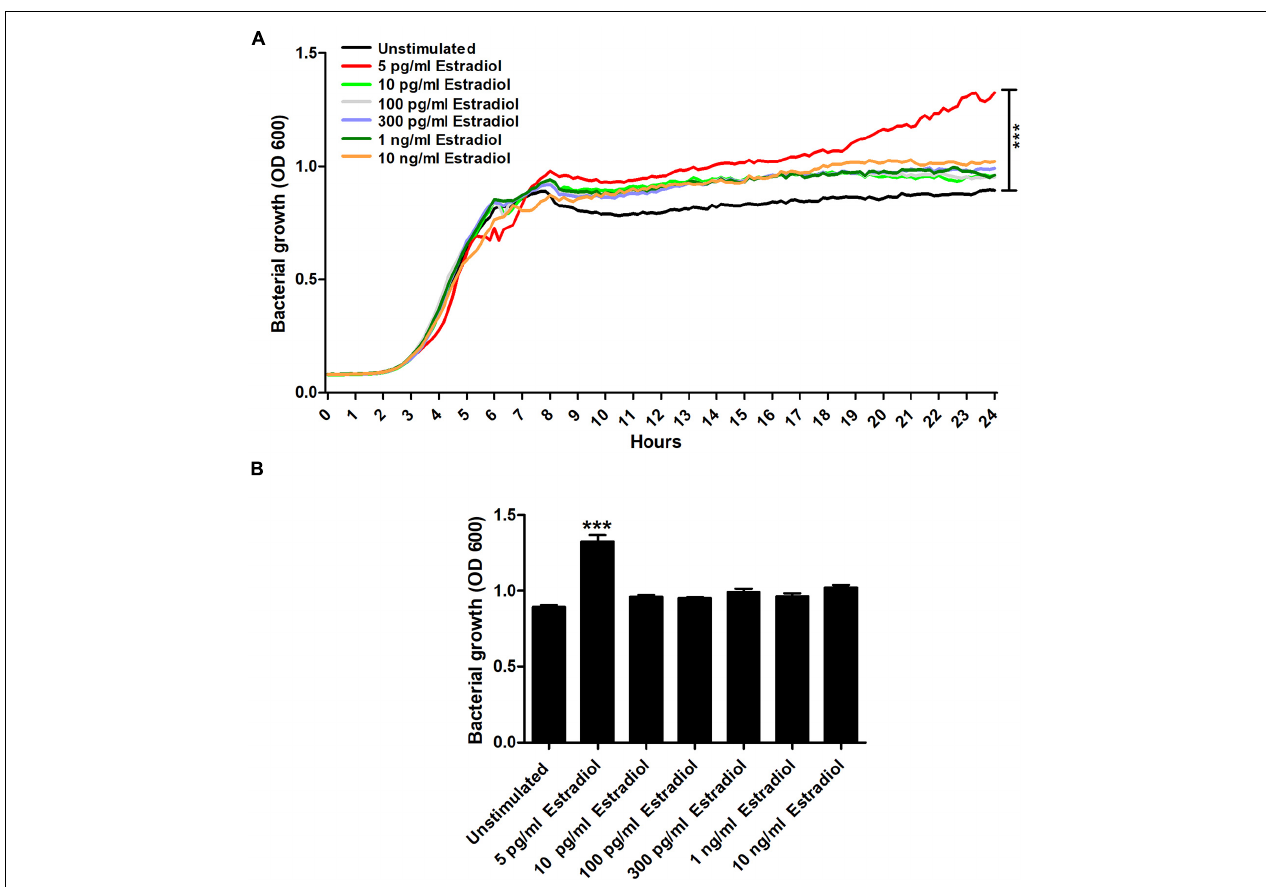
FIGURE 1 | CFT073 growth with or without the presence of estradiol (5 pg/ml, 10 pg/ml, 100 pg/ml, 300 pg/ml, 1 ng/ml, and 10 ng/ml) during 24 h (A) and at 24 h (B) . Data are presented as mean (A) and mean ± SEM (B) of n = 3 independent experiments. The asterisk distinguishes statistical significance: *** p < 0.001 vs. unstimulated